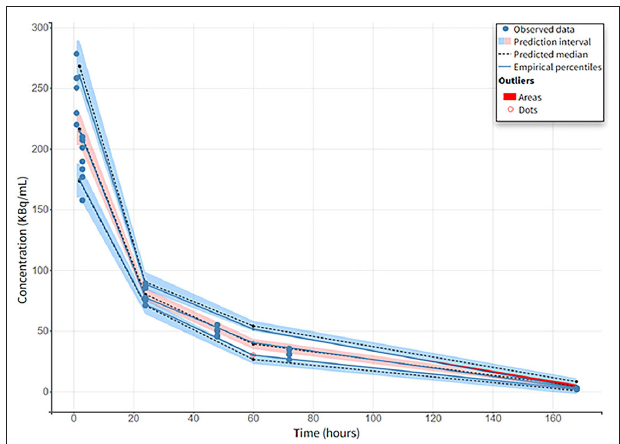
FIGURE 6 | Visual predictive check of 2-CMT model of experimental blood data in healthy mice.